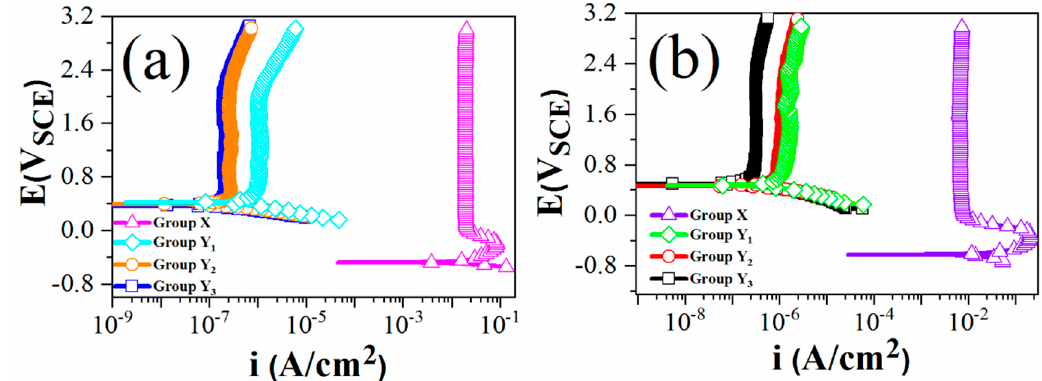
Figure 5. Potentiodynamic polarization curves of groups X, Y 1 , Y 2 and Y 3 at 100 ± 5 °C: ( a ) 4 M HCl; ( b ) 4 M H 2 SO 4 . Table 2. The E corr and I corr values determined from Tafel slopes.